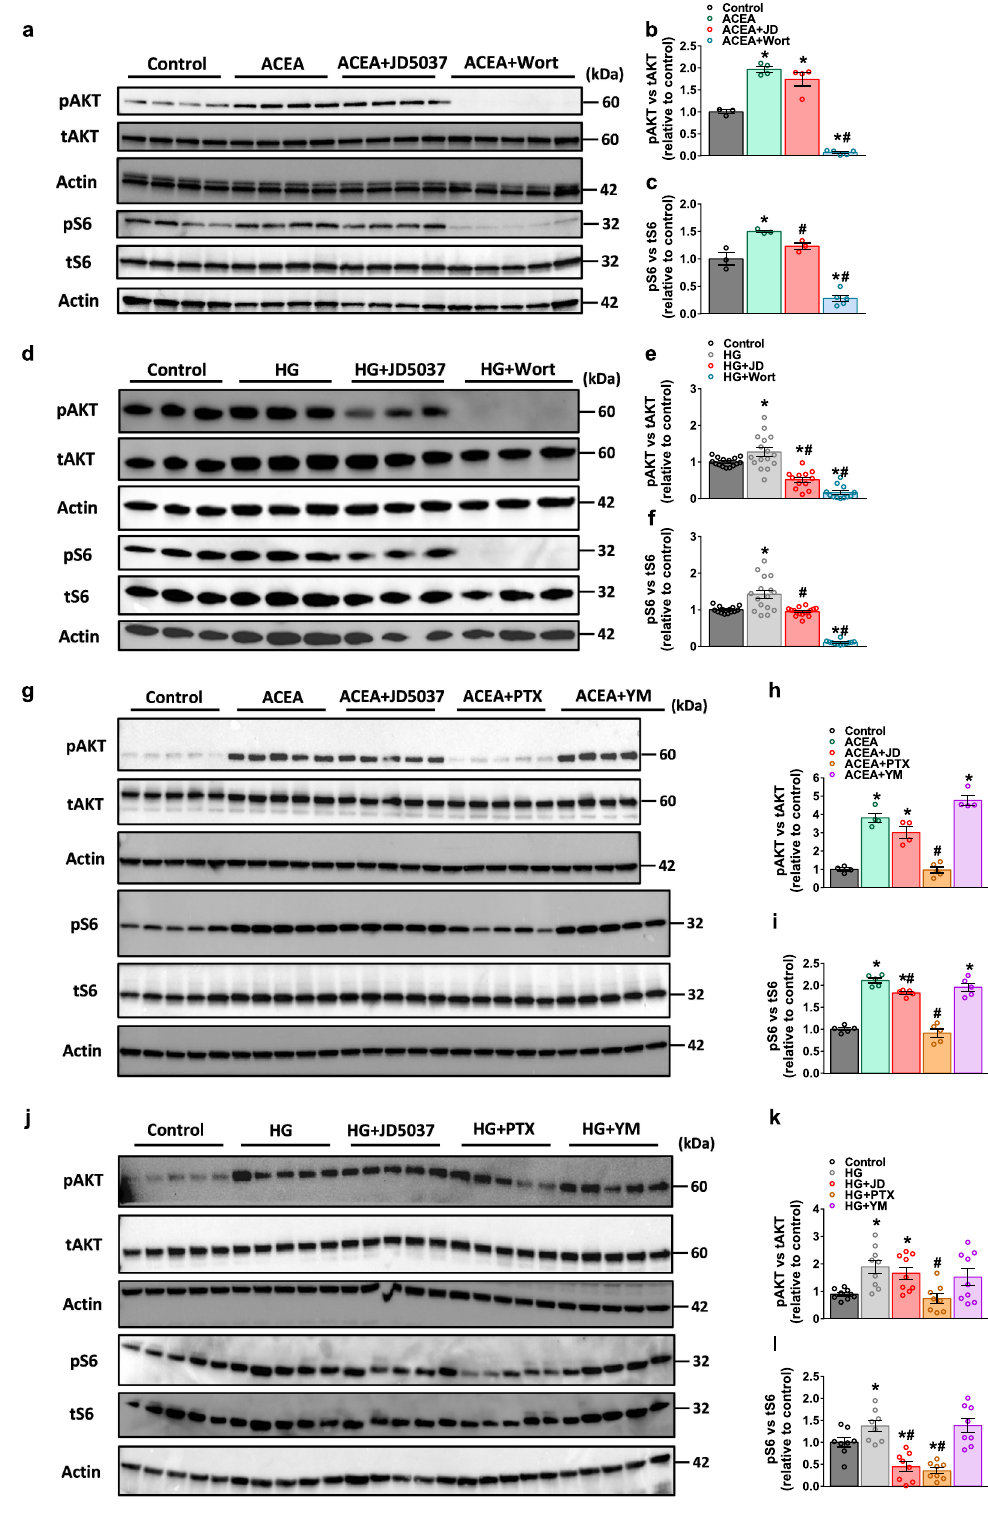
levels (Fig. 4i, j, l, m), and was found to be associated with the GLUT2 protein levels in these mice (Fig. 2c, f, j, l). Moreover, overactivation of mTORC1 in WT-RPTC-TSC − / − mice resulted in enhanced expression of SREBP1 and GLUT2 (Supplementary Fig. 2g, h). To directly link SREBP1 with GLUT2 transcription, we knocked down SREBP1 in hRPTCs using siRNA, whose inhibition signi fi cantly reduced the GLUT2 expression levels under